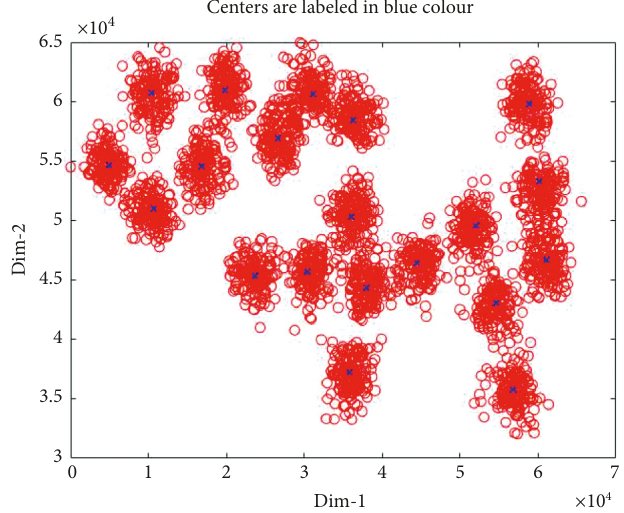
Figure 6: Sample clustering output for the A1